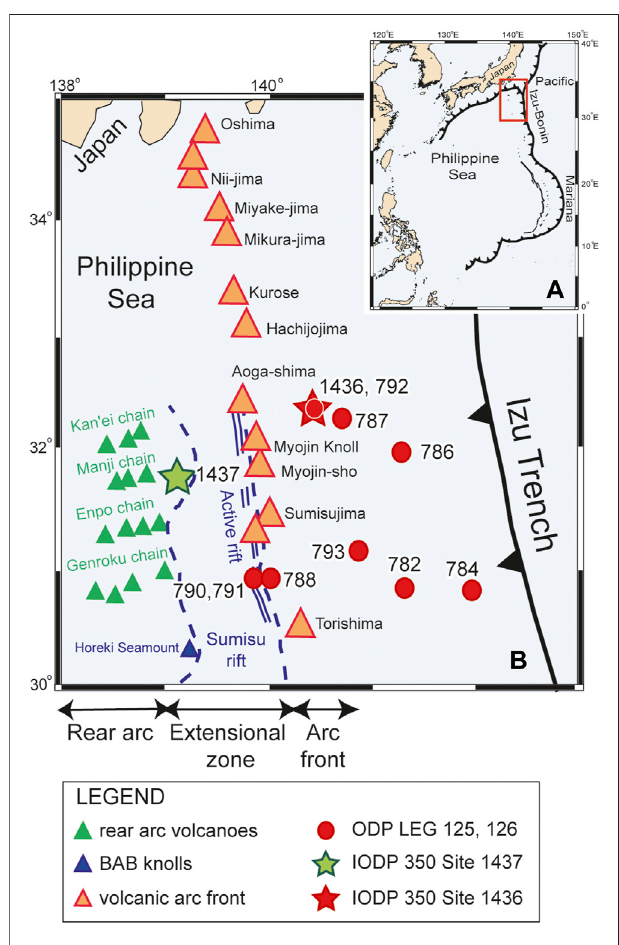
FIGURE 1 | Locality maps. (A) Location of the Izu-Bonin-Mariana intra- oceanic arc system in the Western Paci fi c. The red box shows the area of (B) . (B) Location map of the northern Izu convergent margin. A 100-km wide extensional zone that extends westward from the active rifts, as represented by the blue dashed lines. The location of the IODP and ODP drilling sites used in this study are also plotted. Figure is modi fi ed after http:// publications.iodp.org/scienti fi c_prospectus/350/ and Straub